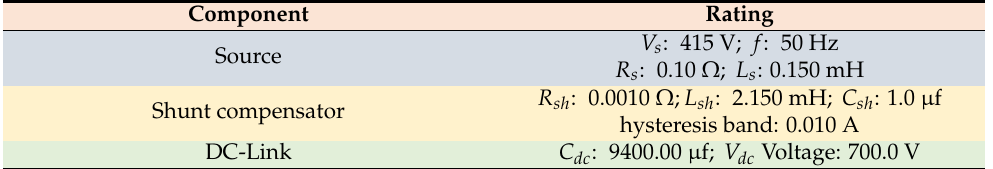
Table 1. SHAPF specifications and loads.